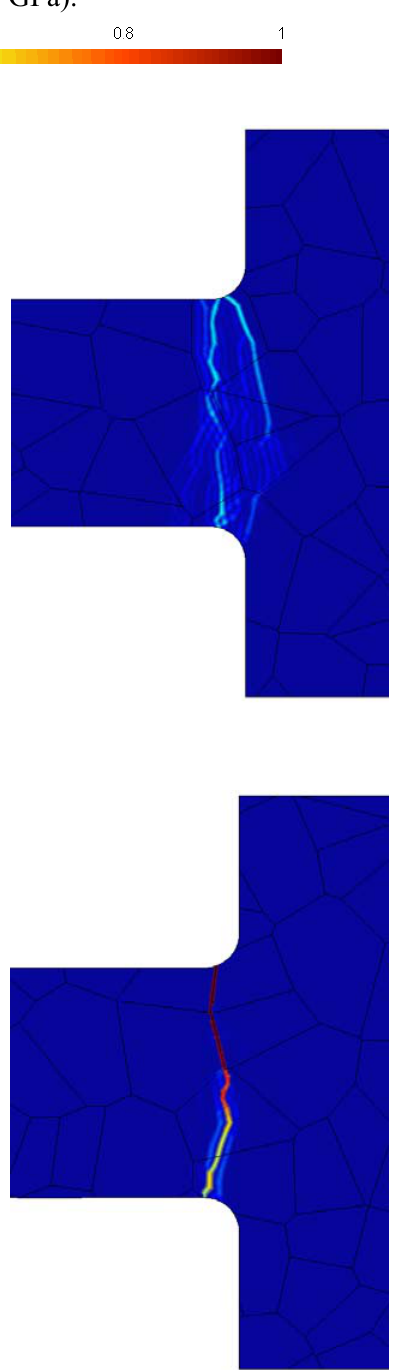
Figure 7. Statistical forecast of the dominant cracks at failure. Top row: micro-structure A; bottom row: micro-structure B. Left column: perfect GBs ( 5.2 right column: defective GBs ( 5.2